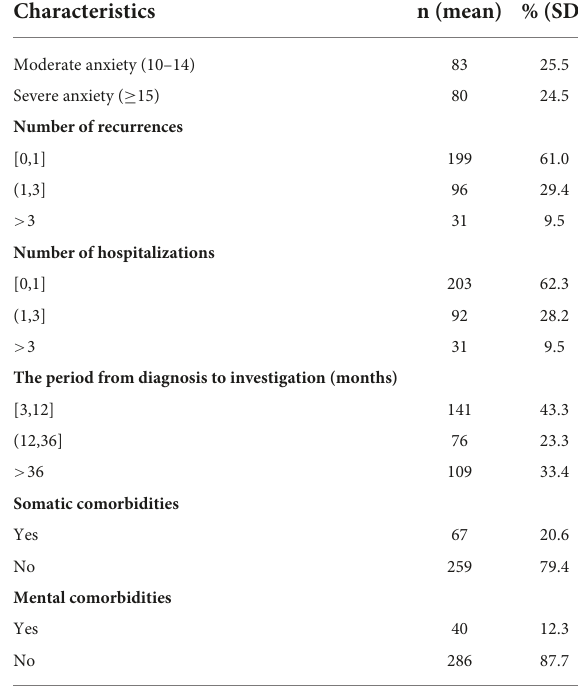
TABLE 1 Sociodemographic and clinical characteristics of the participants ( N =